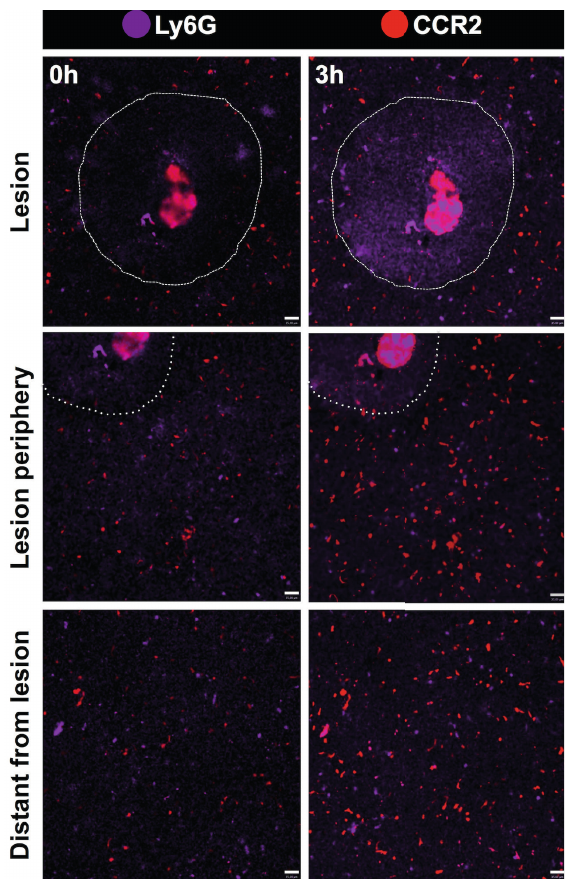
Figure 9 - Dynamics of phagocyte populations under liver injury. Assessing migration dynamics of ly6g + (purple) and CCR2 + (red) to necrotic zones, areas around necrosis and areas distant from necrosis using intravital microscopy. Imaging protocol was made throughout three sequential hours. A focal necrosis was induced using a hot needle adapted to a cauterizer unit. The hot needle touched liver surface and generated a punctual necrosis, which is delimited by the dotted line. Neutrophils correspond to l6yg + CCR2 + cells. Scale bars = 35